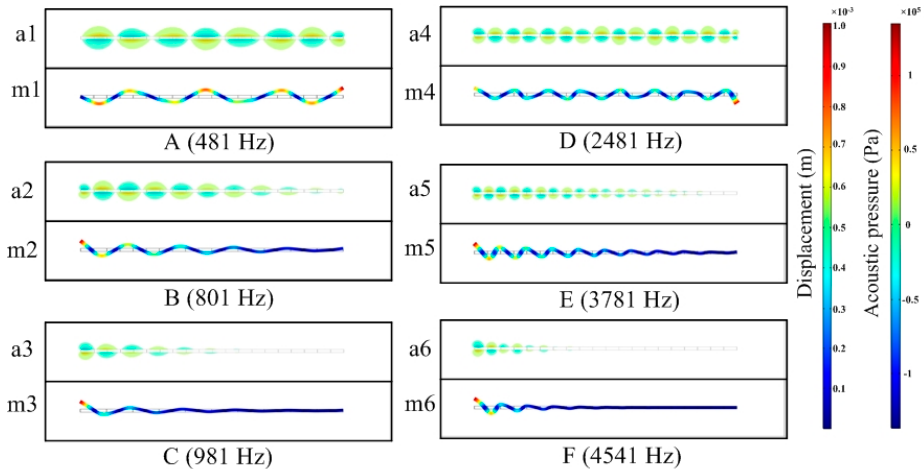
Figure 5. Comparison of the steady-state vibration profiles of the PC beam and the relating acoustic pressure fields (“a” stands for acoustic pressure field and “m” stands for steady-state vibration modes) (color online).